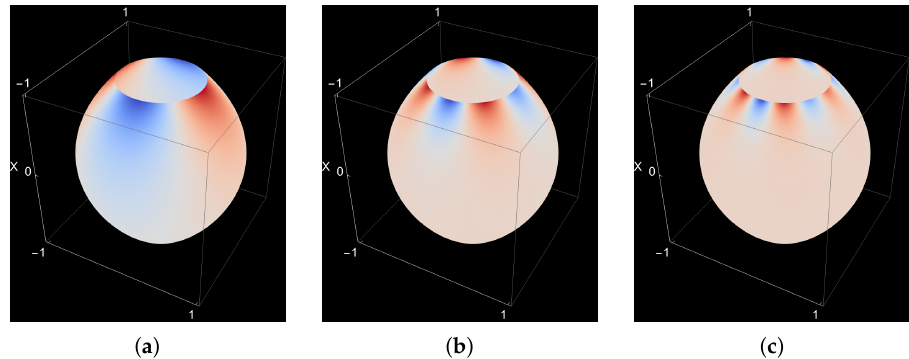
Figure 6. Elliptic case: transverse deflection profiles. ( a ) t = 10 − 2 . Range w ∈ [ − 6.07867,2.67837 ] . ( b ) t = 10 − 4 . Range w ∈ [ − 18,040,13,276.7 ] . ( c ) t = 10 − 6 . Range w ∈ [ − 519,606, 406,531 ]